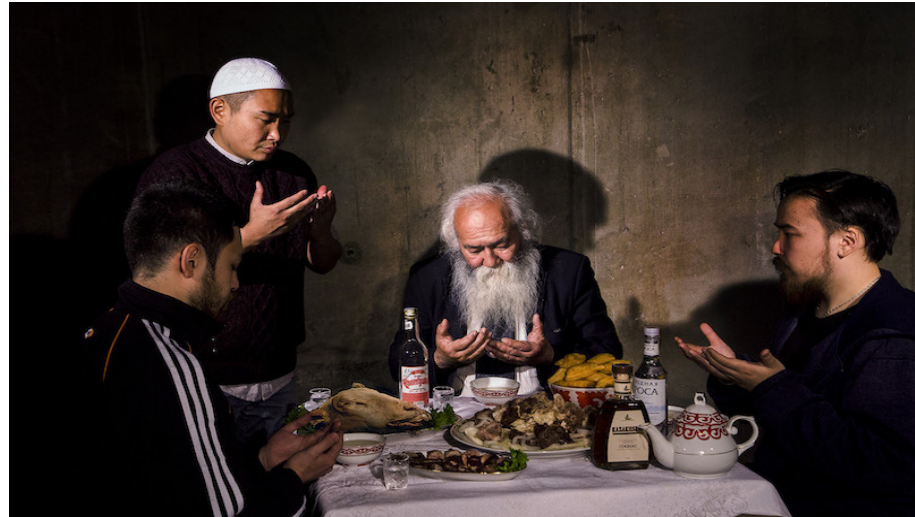
Figure 1. Anvar Musrepov, Prayer (2015). Image courtesy of the artist.